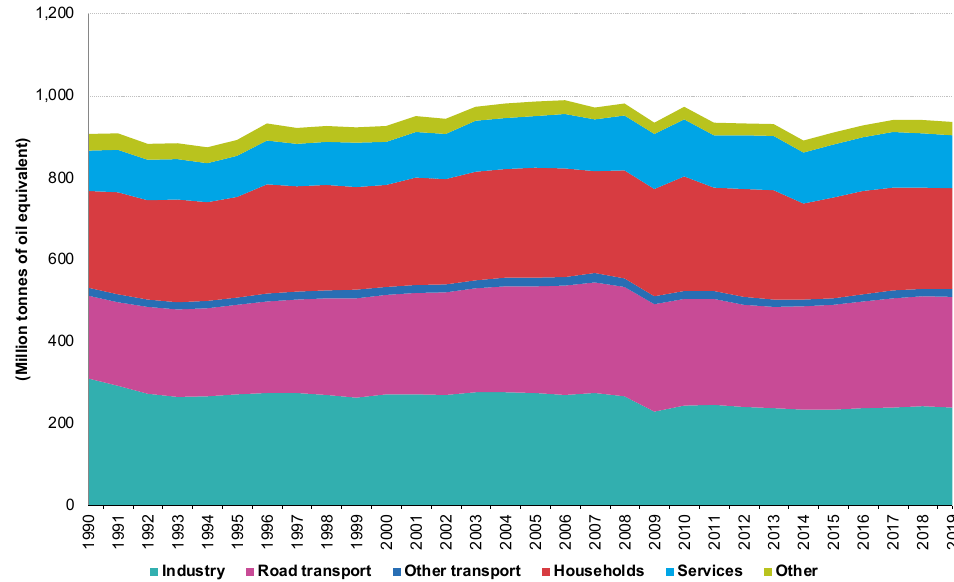
Figure 2. Final energy consumption by sector in the EU from 1990 to 2019, measured in million tons of oil equivalent. The authors created this figure using data from Eurostat [1].